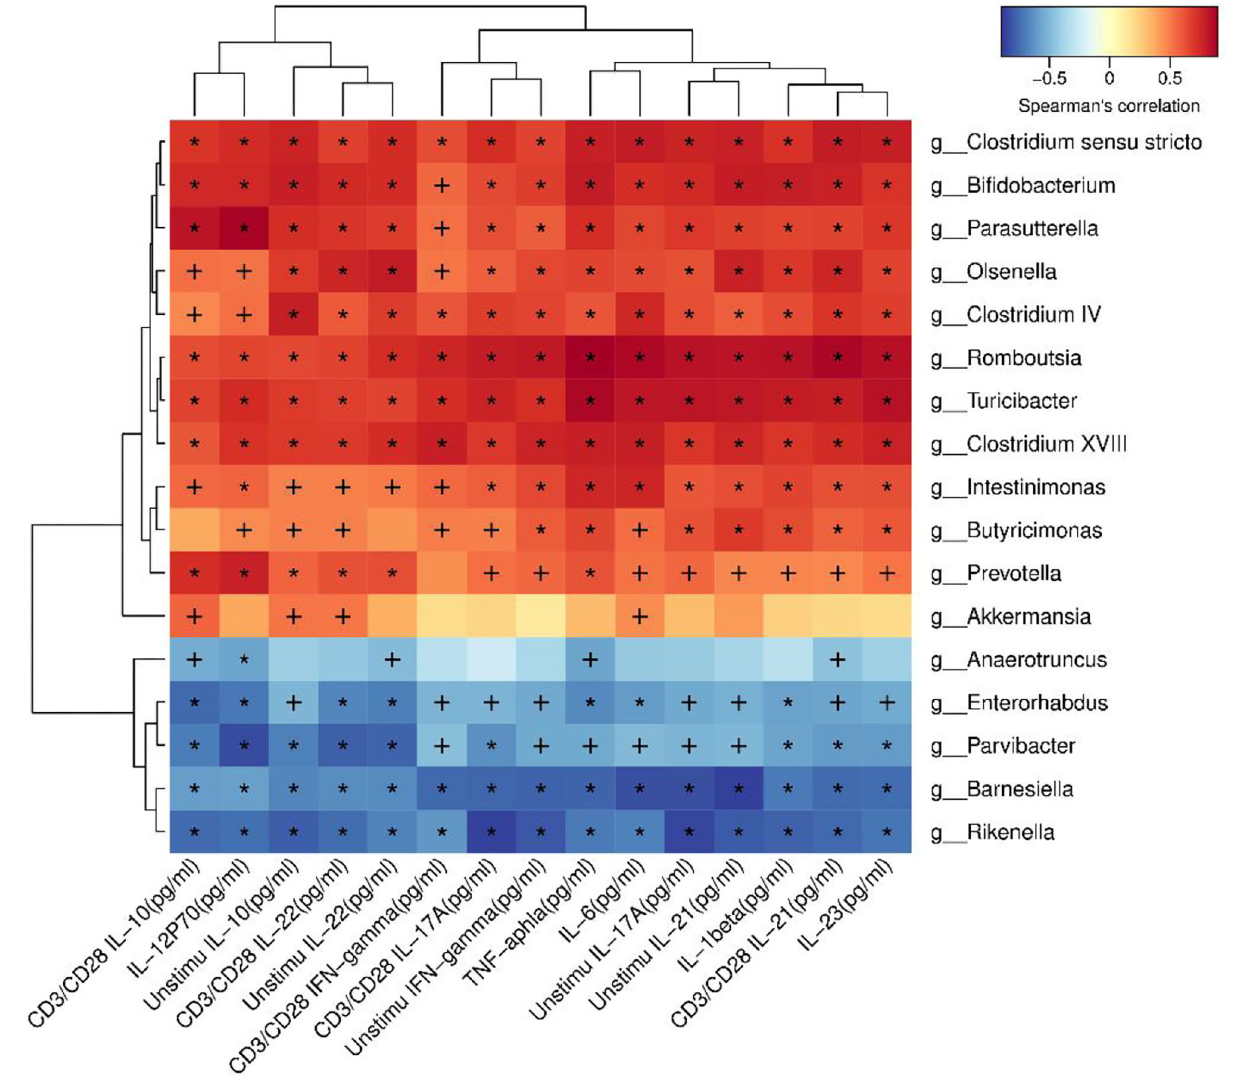
FIGURE 8 | Correlation analysis between microbiota and